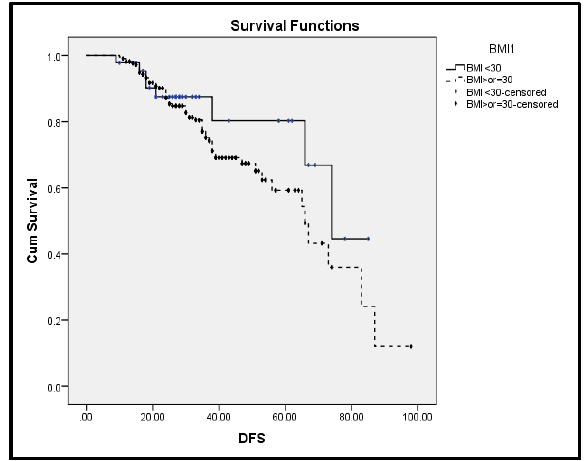
Figure 1: Kaplan Meier Curves of disease-free survival according to BMI cutoff value of 30